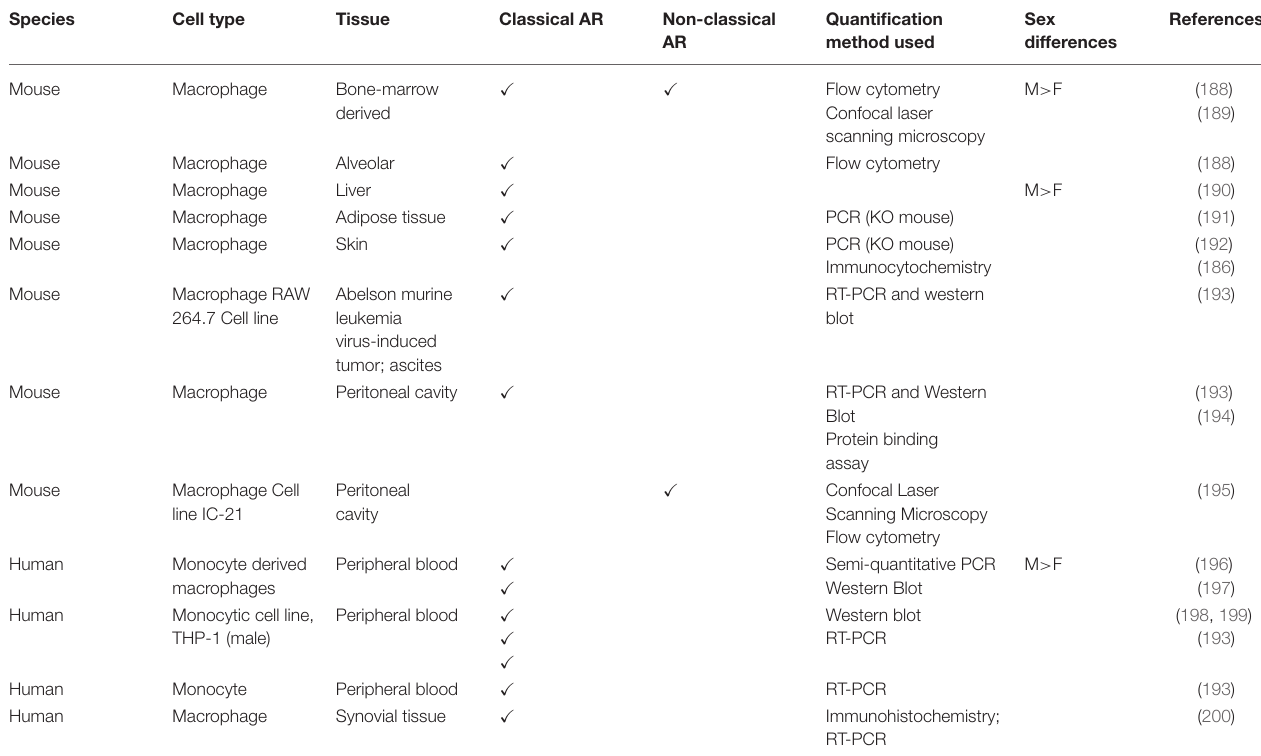
TABLE 1 | Androgen receptor expression in mouse and human monocytes and macrophages.